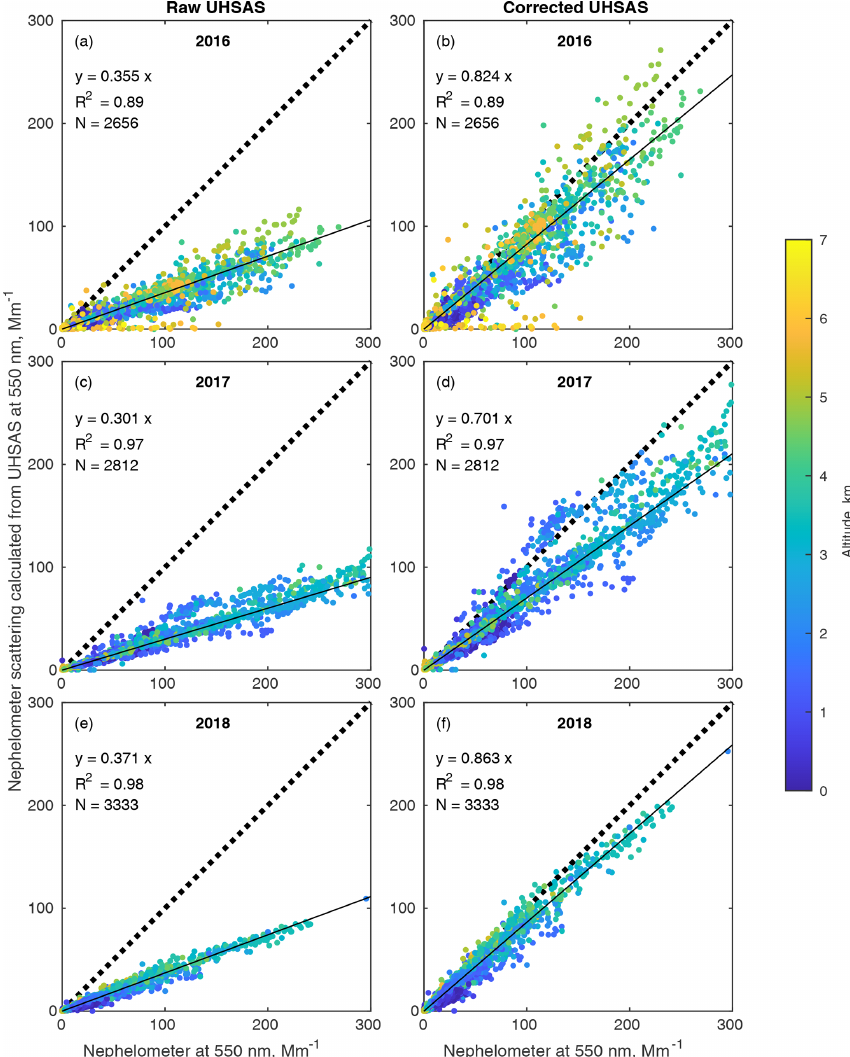
Figure 12. Effect of the proposed correction on scattering closure calculations at 550nm. Plots on the left use uncorrected UHSAS dis- tributions from each year of ORACLES, while those on the right use the corrected distributions. Nephelometer data are uncorrected for truncation error; instead the scattering from the UHSAS size distribution is calculated over the 7 to 170 ◦ sensing range of the nephelometer. The refractive index used in the calculation is 1.588, that of the PSL calibration spheres at visible wavelengths. The 2017 data include a few points above 300Mm − 1 that are not